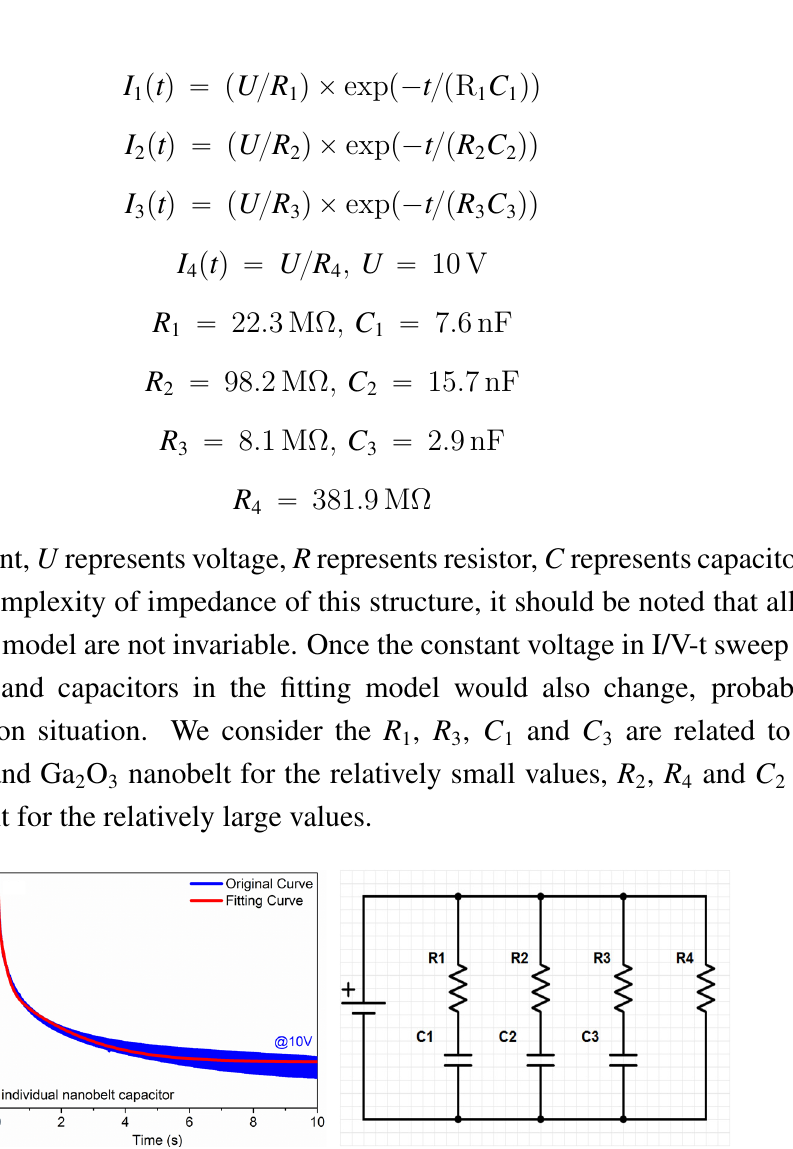
O nanobelt on Pt IDEs, and 2 3 O nanobelt on Pt 2 3